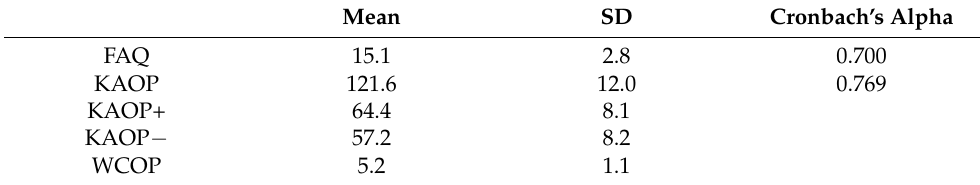
Table 2. Mean and SD of knowledge, attitudes, and willingness (N =